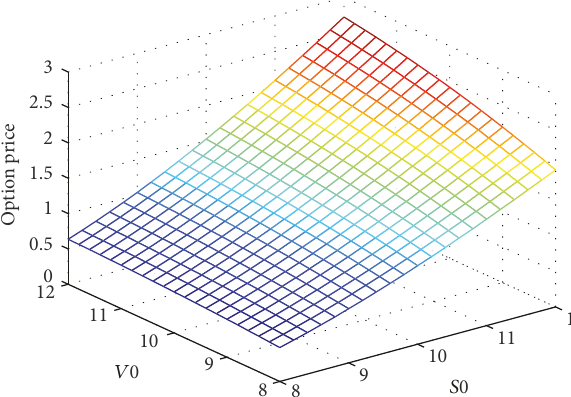
Figure 2: Vulnerable European call option price against the initial prices of 𝑆 and 𝑉 .